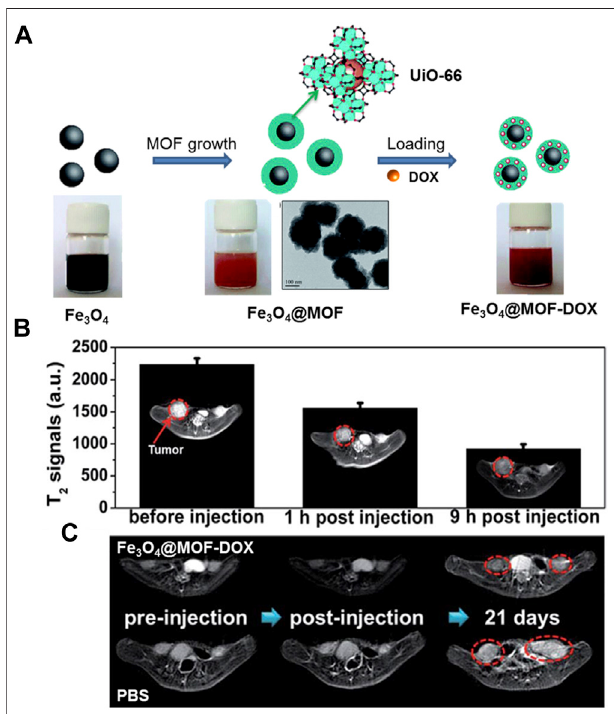
FIGURE 9 | (A) The schematic illustration of the fabrication of Fe 3 O 4 @ MOF core – shell composites. (B) T2-weighted MR images and T2-MR signals oftumoronHeLa-tumorbearingmicebeforeinjection,1and9 hpostinjection ofFe 3 O 4 @UiO-66intravenously(tumorregionmarkedbyredcycles). (C) MRI of HeLa-tumor bearing mice treated with PBS or Fe 3 O 4 @UiO-66-DOX collected at different time points (tumor region marked by red cycles). Source: (Zhao et al.,